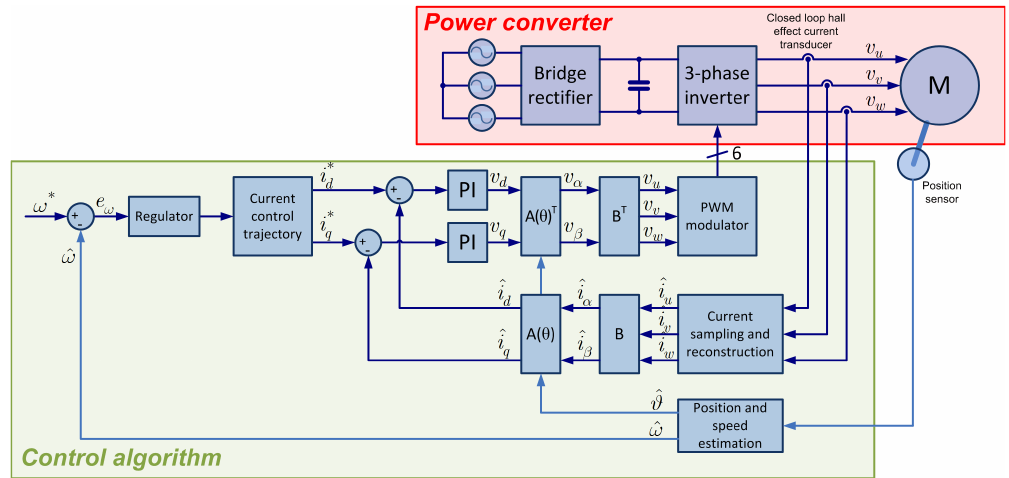
Figure 2. Block scheme of the control for a three-phase motor drive